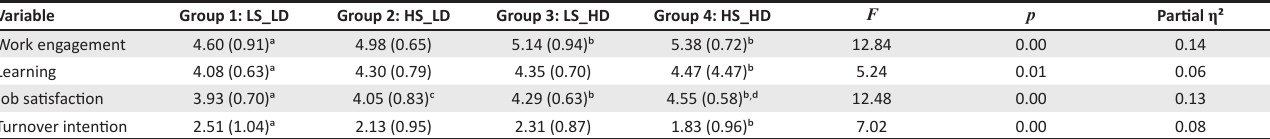
TABLE 4: Between-group differences based on work engagement, learning, job satisfaction and turnover intention.